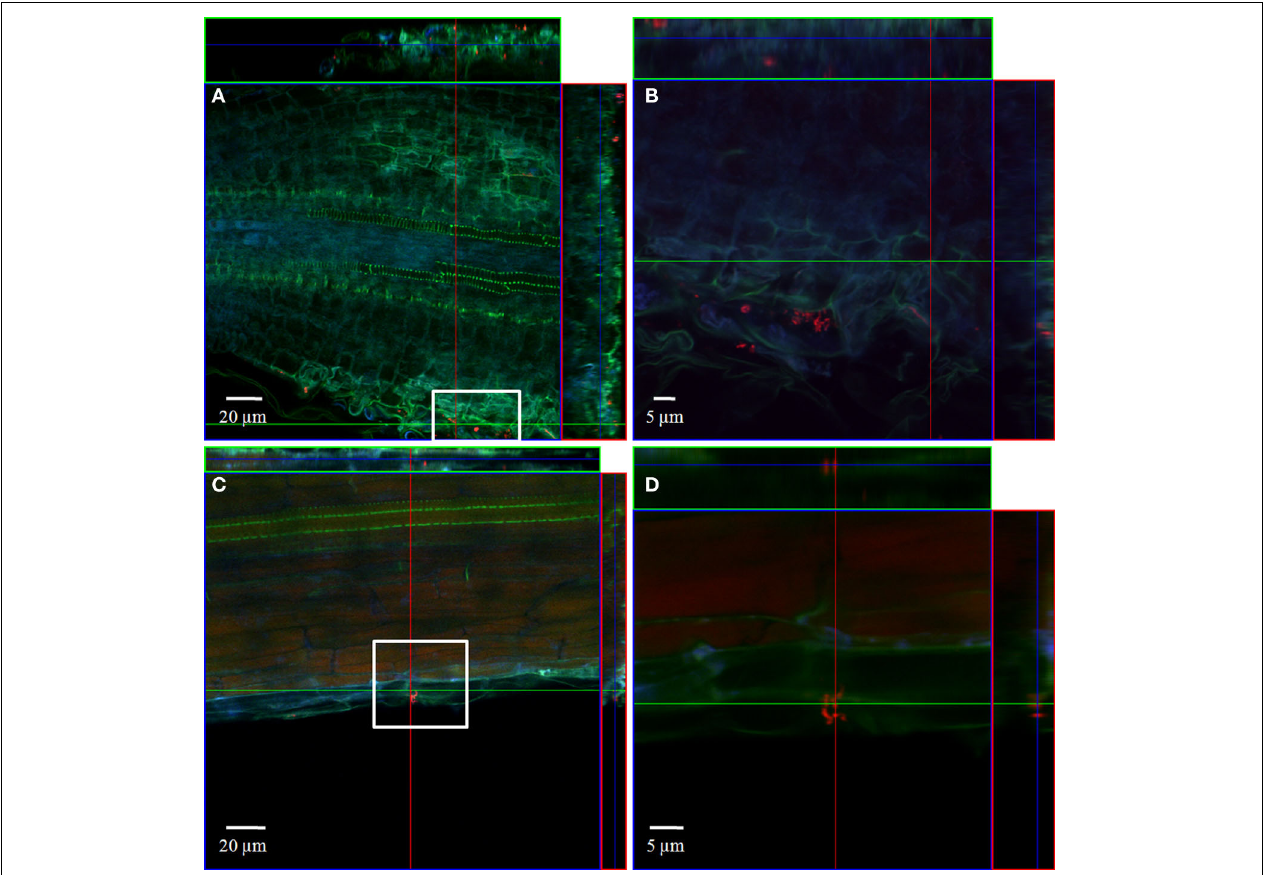
after 3 weeks of growth in an axenic system. Probe Cy3 marked EUB-338, I, II, III was applied during FISH procedure (red signal). (B) is an enlarged capture of the area marked in (A) , (D) is an enlarged capture of the area marked in (C)